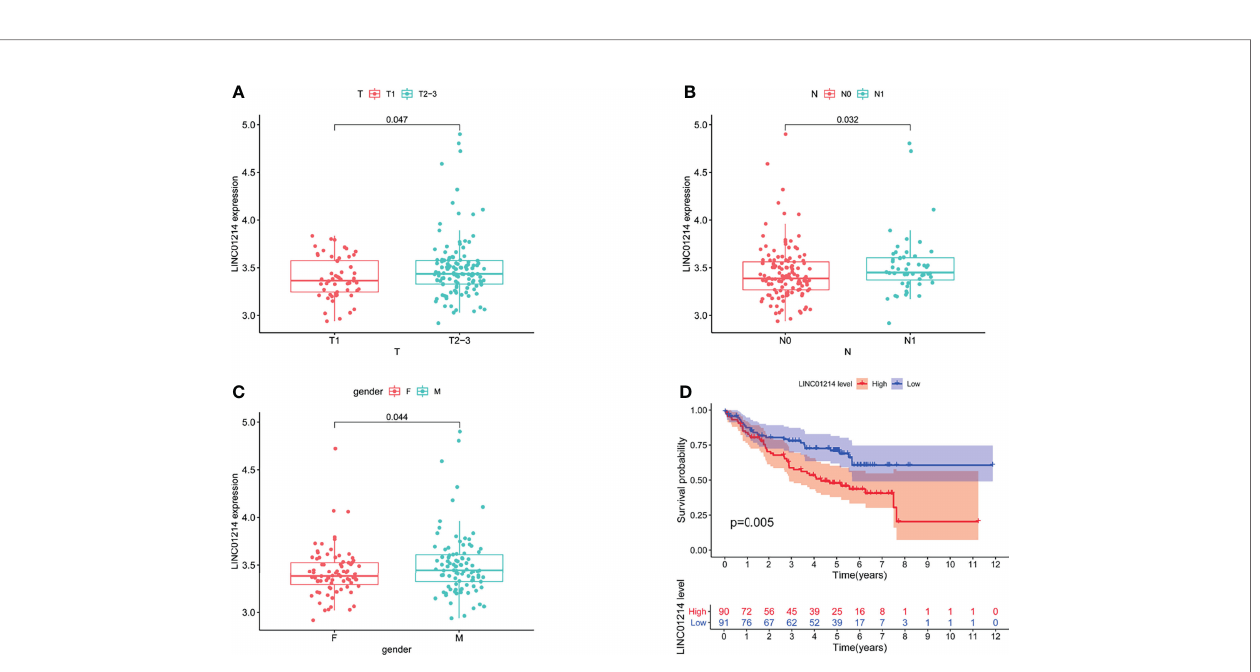
FIGURE 9 | Performance evaluation of LINC01214 in GSE50081 dataset. (A) Boxplots for LINC01214 expression among patients with different T stage (tumor size) in GSE50081 dataset. (B) Boxplots for LINC01214 expression among patients with different N stage (lymph node metastasis) in GSE50081 dataset. (C) Boxplots for LINC01214 expression among patients with different gender in GSE50081 dataset. (D) Kaplan Meier curve analysis was used to verify the overall survival rate of LINC01214 expression level in GEO database in different groups based on